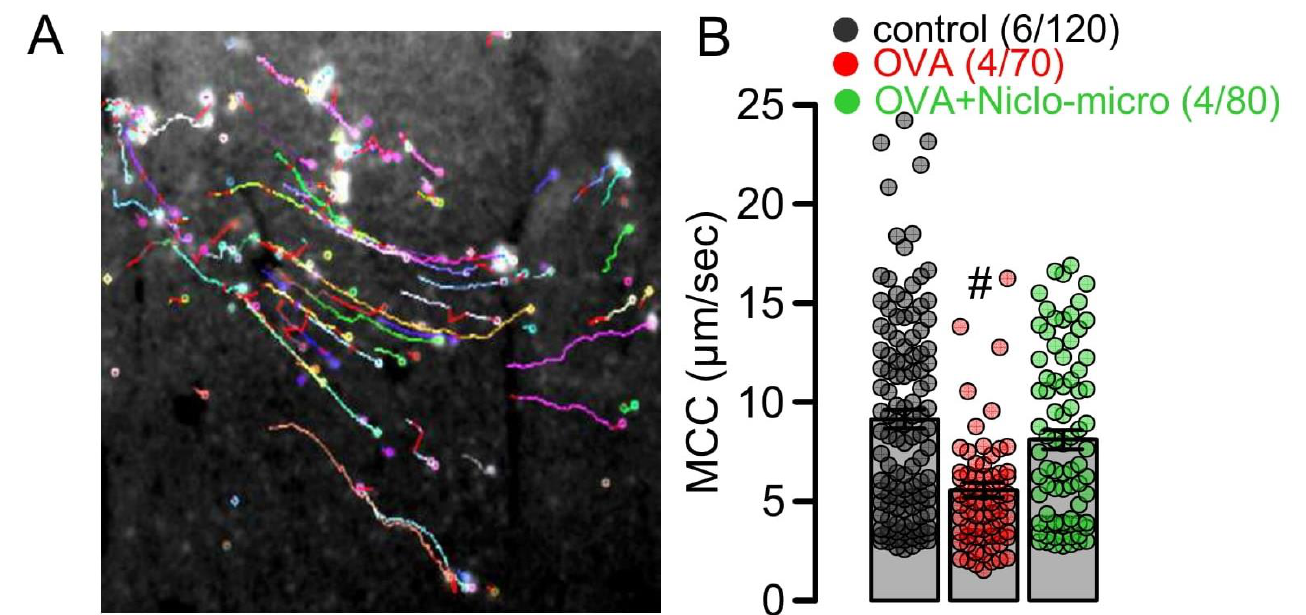
Figure 3. Effect of Niclo-spheres on mucociliary clearance. ( A ) Image from particle tracking in mouse trachea ex vivo, as a measure mucociliary clearance. ( B ) Summary for particle movement ( µ m/s) as a measure for mucociliary clearance (MCC) in tracheas ex vivo indicates that niclosamide-microspheres (0.98 mg; 30 µ M) augment MCC that was reduced in tracheas of OVA-treated animals. Mean ± SEM (number of animals/number of measurements). # significant difference from control ( p < 0.05, ANOVA).